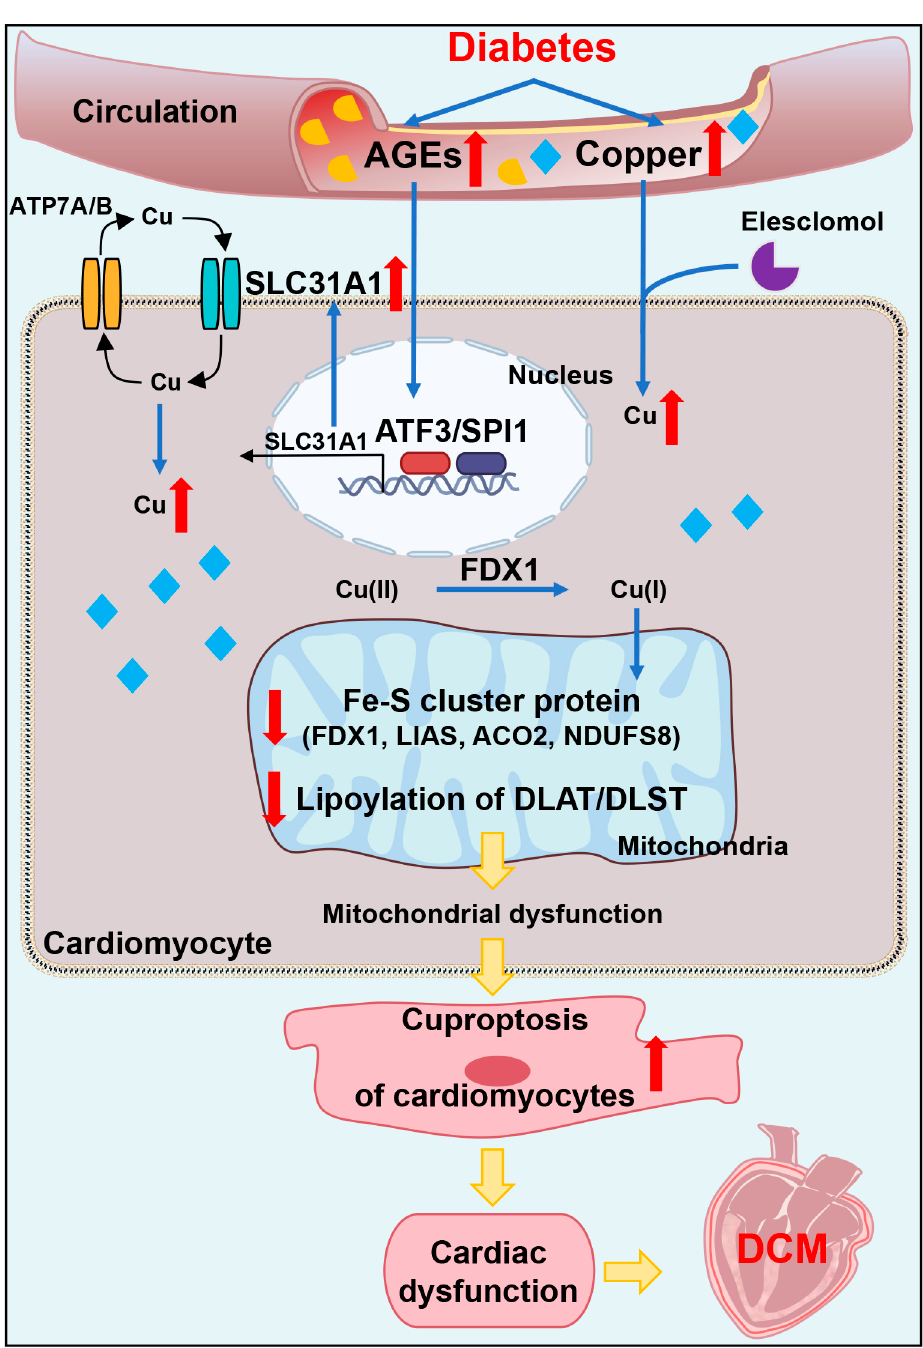
Figure 7. Schematic of mechanisms of AGEs–CuCl2-induced cuproptosis via ATF3/SPI1/SLC31A1 pathway in diabetic cardiomyopathy. Excessive AGEs and copper in diabetes upregulated copper importer SLC31A1 through ATF3/SPI1, thereby mediating copper accumulation in cardiomyocytes, disturbing copper homeostasis and promoting cuproptosis. This promoted the decline of Fe–S cluster protein (FDX1, LIAS, NDUFS8 and ACO2) and decreased lipoylation of DLAT- and DLST-aggravated mitochondrial dysfunction in cardiomyocytes and resulted in myocardial dysfunction.